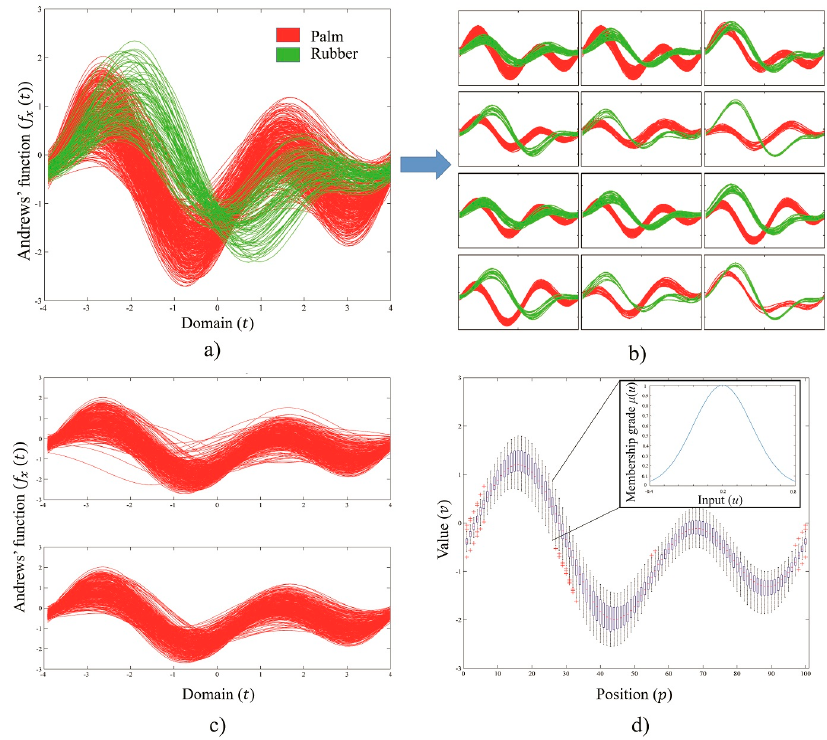
Figure 3. ( a ) Andrews’ curves of a PM ’s training set ( red ) plotted together with an RB ’s training set (green); ( b ) Example of the distribution of the two training sets that seem more separable than ( a ); ( c ) Comparison of the PM ’s training set before ( upper ) and after ( lower ) noise removal; ( d ) Set of Gaussian membership functions generated from the mean and standard deviation of a set of training values at the same position.